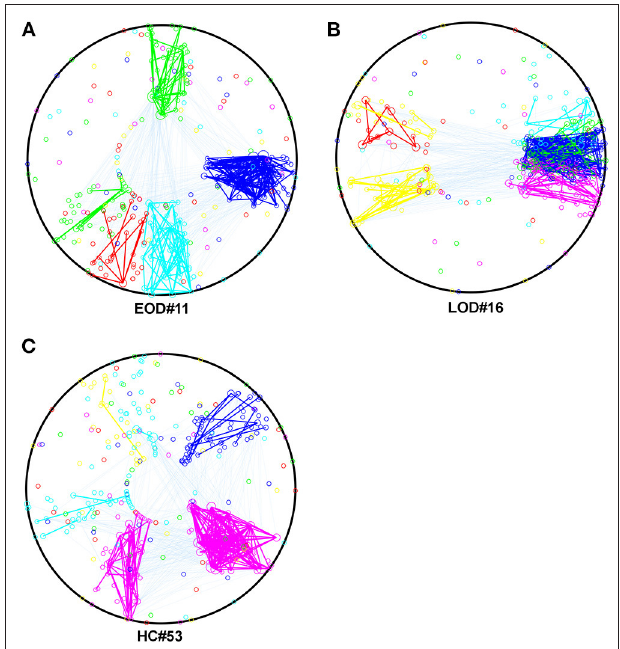
FIGURE 2 | (A–C) The within and between module connection in EOD, LOD, and HC, respectively in 2% sparsity network, the within module connections were represented by the same color of the module, the between module connections were cyan. The color of the module was determined by the script randomly. Mapping was using The Community Detection Toolbox and Maltab home make program.